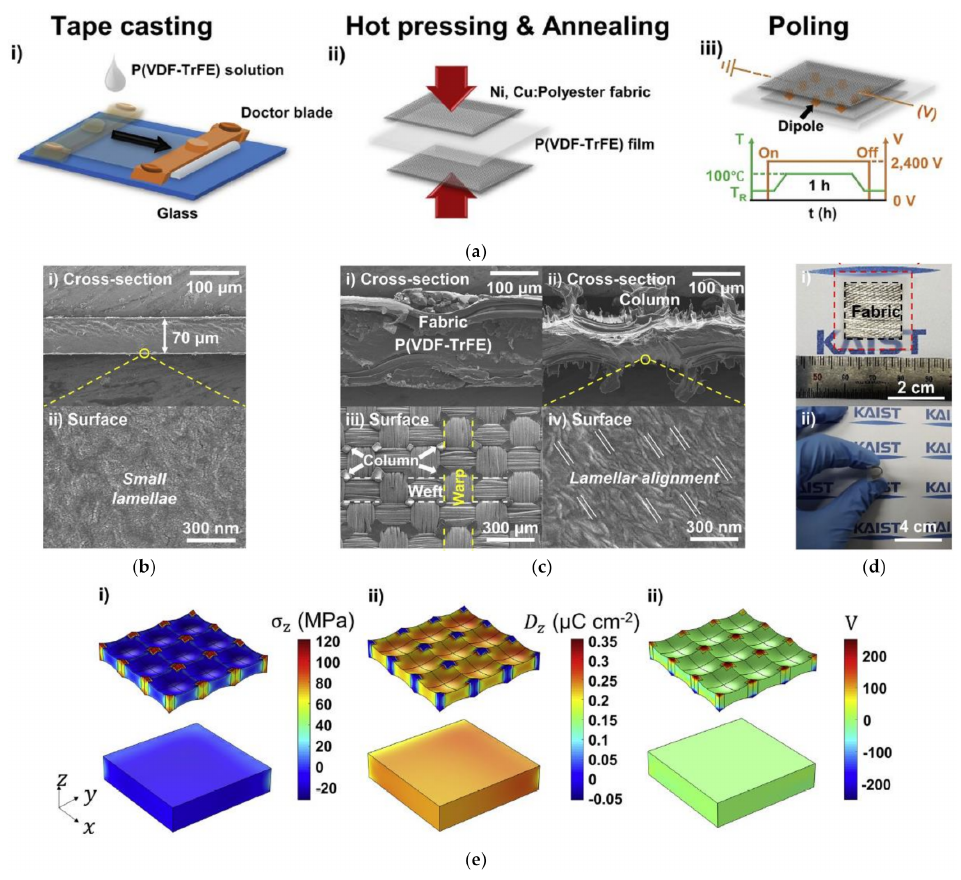
Figure 3. Fabrication steps of the WPEH textile proposed in [61]: (i) Tape casting of P(VDF-TrFE) layer; (ii) P(VDF-TrFE) heterostructure hot-pressed and annealed on a fabric (iii) Electric poling of the resulting a fabric-WPEH to align the ferroelectric dipoles ( a ). SEM images of: (i) cross-sectional and (ii) top views of the deposited P(VDF-TrFE) film ( b ). SEM pictures of a fabric-WPEH: Cross-sectional (i), (ii) and top views (iii), (iv) of the P(VDF-TrFE) film downwards hot-pressing and annealing phases ( c ). Pictures of a fabric WPEH to testify its flexibility ( d ). (i) stress along the z-axis, (ii) electric displacement field, and (iii) distribution of the piezoelectric potential ( e )